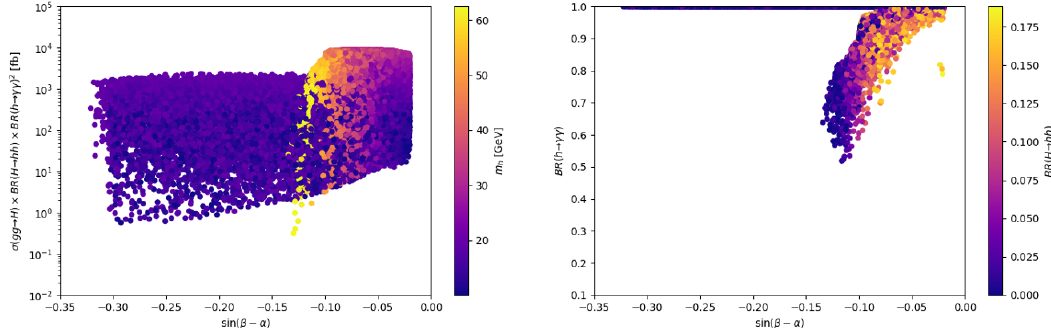
Figure 3. (Left) The (cid:27) 4 (cid:13) rate as a function of sin( (cid:12) (cid:0) (cid:11) ) with m h indicated on the right vertical axis. (Right) The BR( h ! (cid:13)(cid:13) ) as a function of sin( (cid:12) (cid:0) (cid:11) ) with BR( H ! hh ) indicated on the right vertical axis. Both plots are for